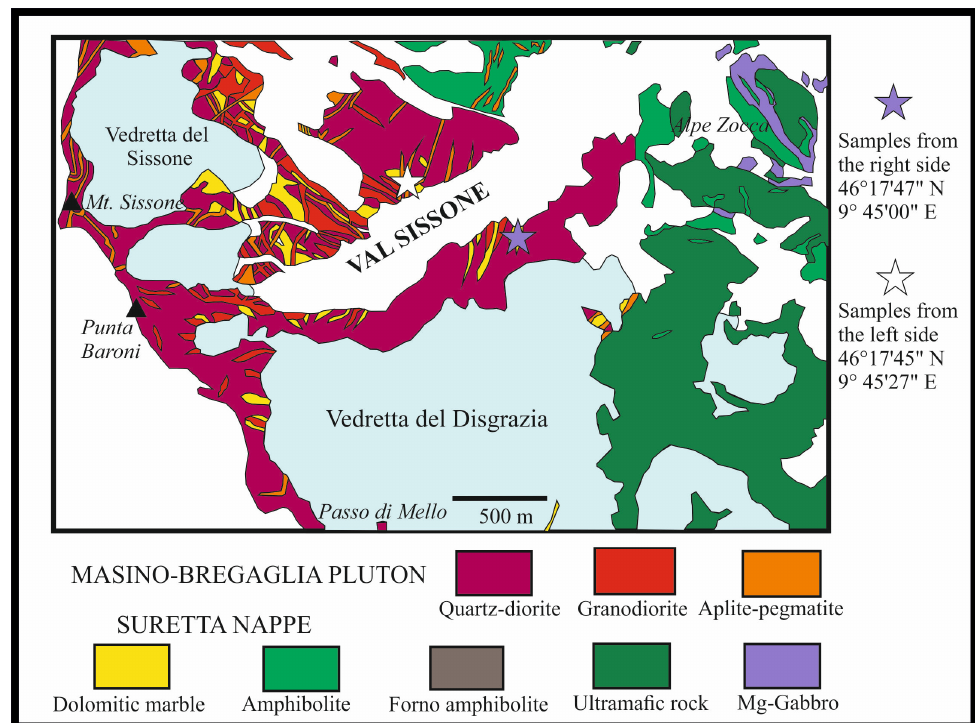
Figure 3. Geological map of the Sissone valley, with the location of the studied specimens (stars). Map redrawn from [14].